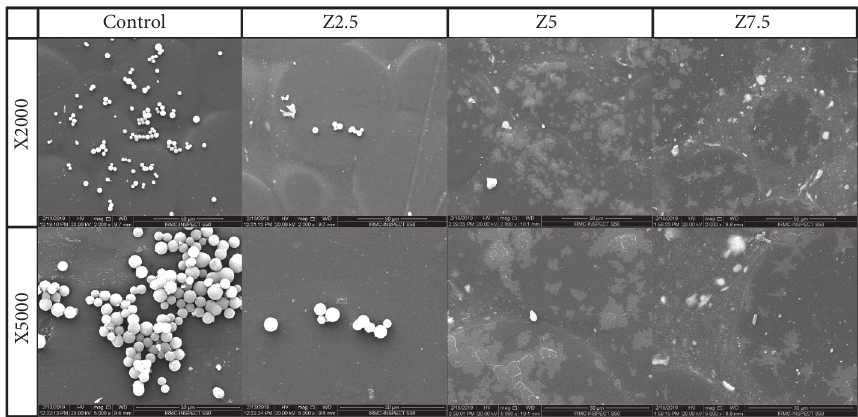
Figure 1: SEM images of acrylic specimens at two magnifications: x2000 (top row) and x5000 (bottom row). Columns from left to right are showing control, 2.5% nanozirconia-modified specimen, 5.0% nanozirconia-modified specimen, and 7.5% nanozirconia-modified spec- imen, respectively. Table 1: Mean (SD) and statistical results of ANOVA and Tukey’s post hoc tests for surface roughness ( μ m) and Candida count (CFU/mL) for pure and modified acrylic resin specimens.